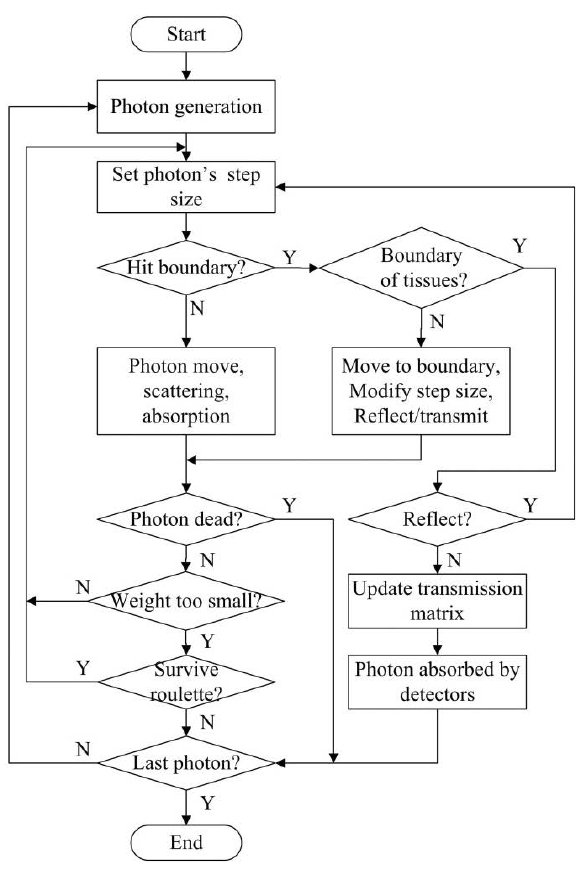
Fig. 1. Flow chart of MC simulation of light propagation in tissues. Here, \Boundary of tissues" means the boundary between the tissue and ambient